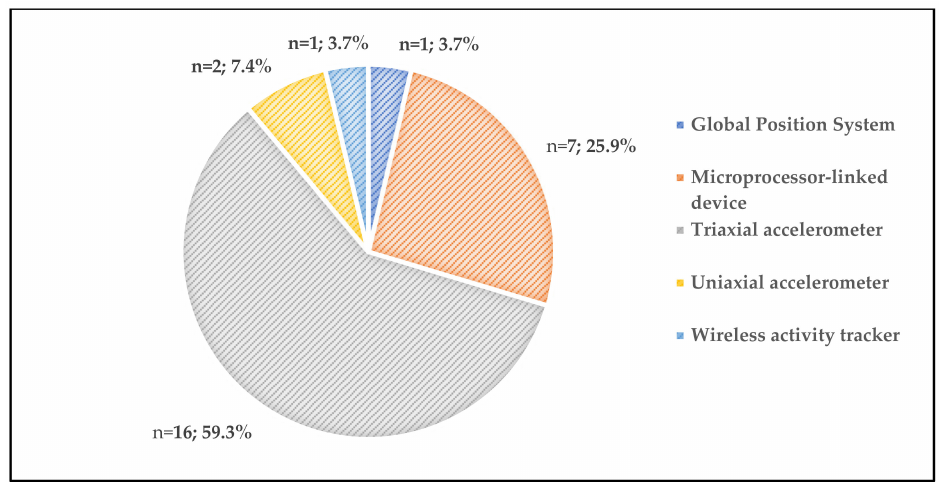
Figure 4. Proportion type of wearable devices used in the included studies ( n ; %).